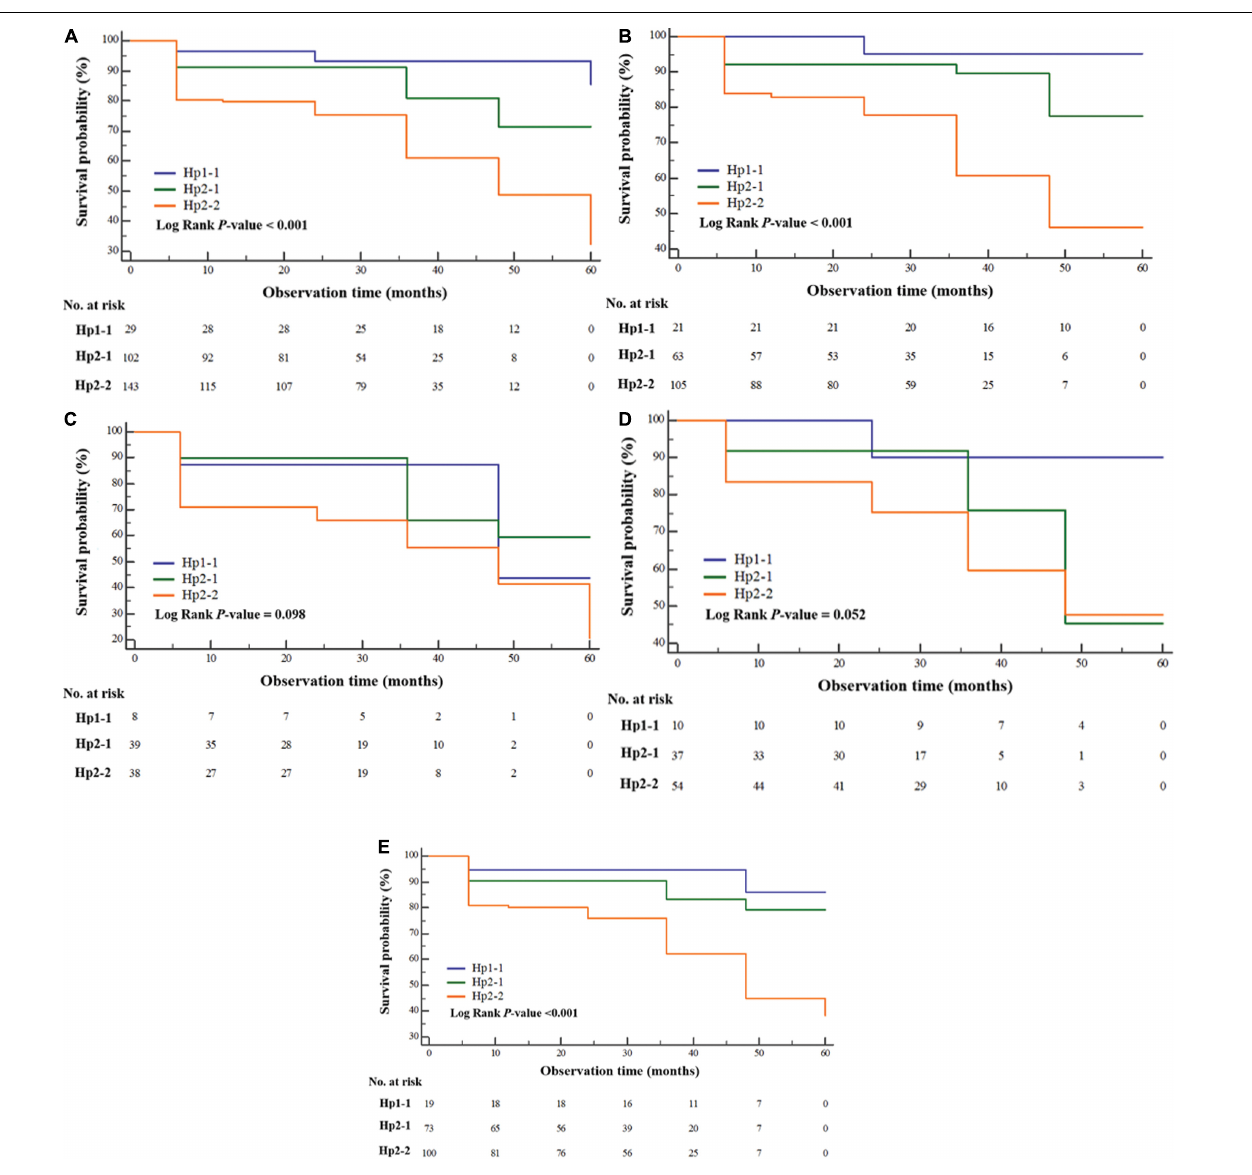
FIGURE 2 | Kaplan-Meier survival curve illustrating the cumulative cognitive impairment-free survival probability according to haptoglobin phenotype (A) and subgroup analyses of patients aged < 65 years (B) and ≥ 65 years, including (C) men (D) and women (E) after subarachnoid